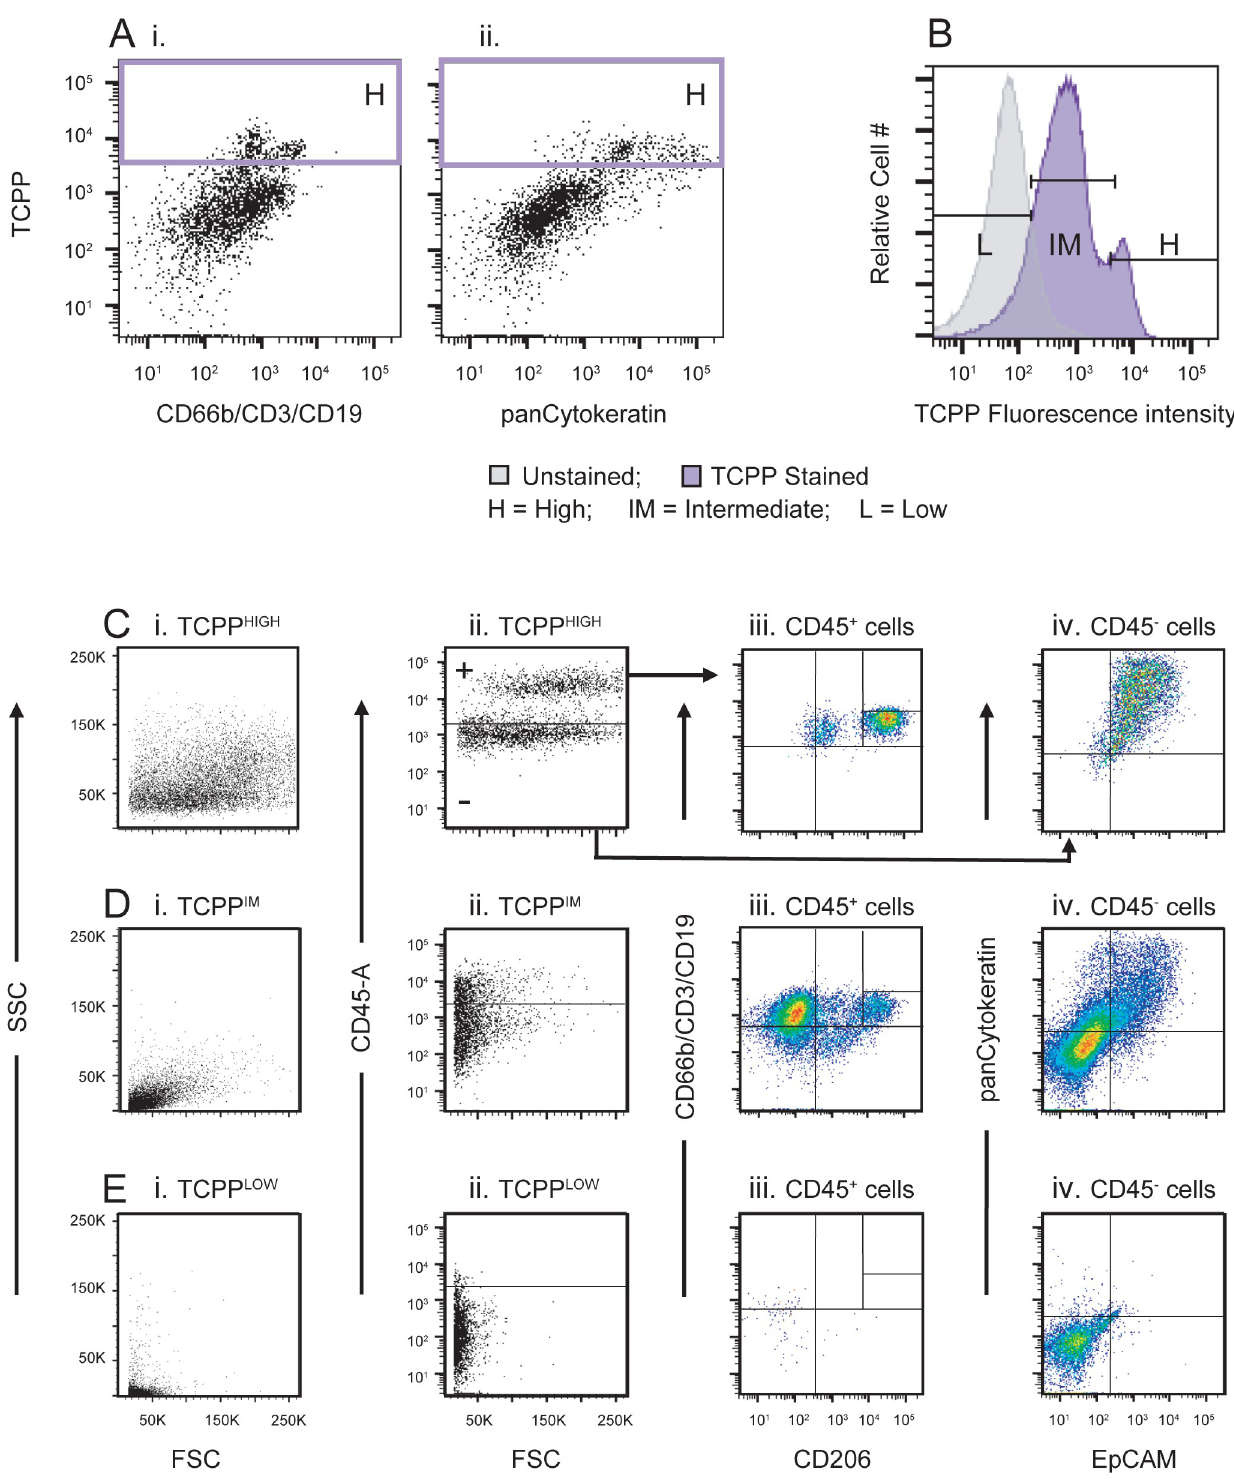
Fig 6. Sputum cells highly stained with TCPP represent unique subpopulations. A, B ) Defining sputum cell populations with different TCPP fluorescence intensities (FI). A ). The dot plot displaying TCPP versus FITC/Alexa488 fluorescence (i.e., CD66b/CD3/CD19 in the leukocyte tube (Ai) and panCK in the non-leukocyte tube (Aii)) is used to define the TCPP HIGH cut-off. The TCPP versus PE-CF594 fluorescence plot (not shown) can also be used for this purpose but the cells with the highest FI for TCPP are easier to identify in the former. B ) Representative histogram of the TCPP FI. The TCPP HIGH cut-off is taken from the gate shown in panel A . The TCPP LOW population is defined at the intersect when unstained sputum is overlaid with the TCPP-